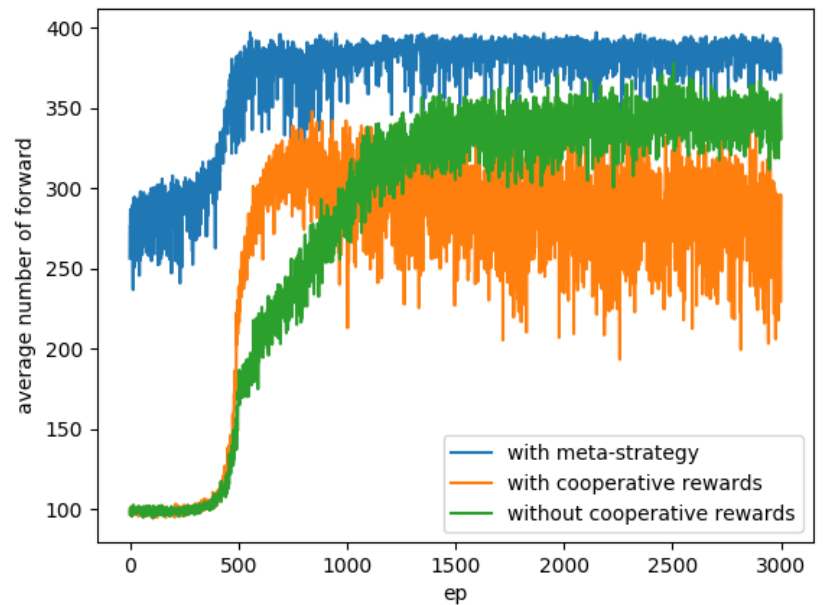
Figure 5. Number of agents choosing forward with meta-strategy, with cooperative rewards and without cooperative